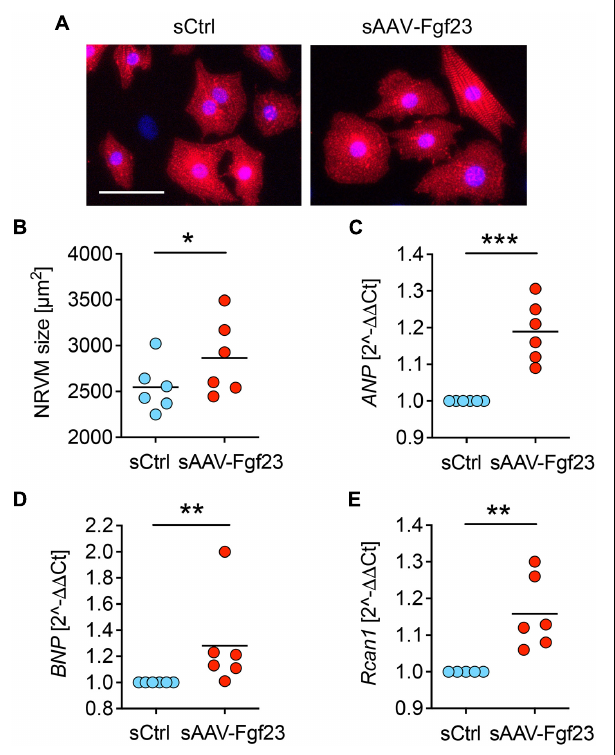
FIGURE 3 | Serum of AAV-Fgf23 mice induces cardiac hypertrophy of NRVM. (A) Representative immunofluorescence images of isolated neonatal rat ventricular myocytes (NRVM) stimulated with 2% serum from AAV-Fgf23 (sAAV-Fgf23) or Ctrl (sCtrl) mice for 48 h. Myocytes are labeled with anti- α -actinin (red) and nuclei are counterstained with DAPI (blue) (original magnification × 20; scale bar 50 µ m). (B) Quantification of the cross-sectional area of NRVM reveals hypertrophic cell growth due to treatment with sAAV-Fgf23 compared to sCtrl (mean of 100 cells per condition and isolation). (C–E) Quantitative real-time PCR analysis shows increased expression of ANP , BNP , and Rcan1 in sAAV-Fgf23-treated NRVM compared to sCtrl. Data are given as scatter dot plots with means; * p < 0.05, ** p < 0.01, *** p < 0.001 analyzed using unpaired t -test or Mann–Whitney test according to Shapiro–Wilk normality test; n = 6 independent isolations of